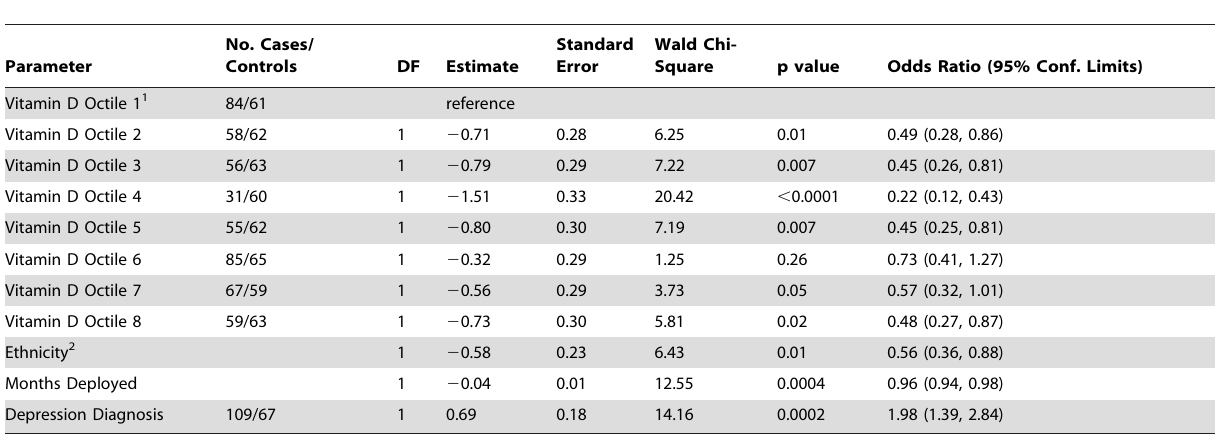
Table 2. Results of the conditional logistic regression analysis including covariates.